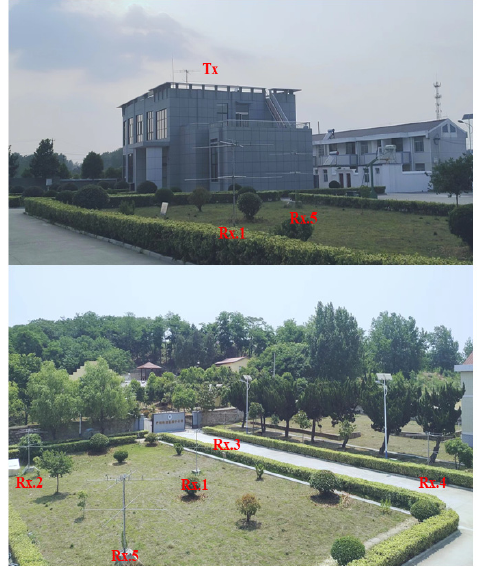
Figure 1. Panoramic view of the Mengcheng meteor radar receiving antenna array. Tx represents the transmitting antenna, and Rx. 1–5 represent the five receiving antenna elements. The MCMR radar system is an atmospheric radar system (ATRAD) weather-detection radar, as suggested by Holdsworth et al. [23]. MCMR transmits a 38.9 MHz pulsed coherent radio signal with a wavelength of 7.71 m and a peak power of 20 kW. A 4-bit code and a pulse repetition frequency (PRF) of 430 Hz are adopted by the MCMR with four